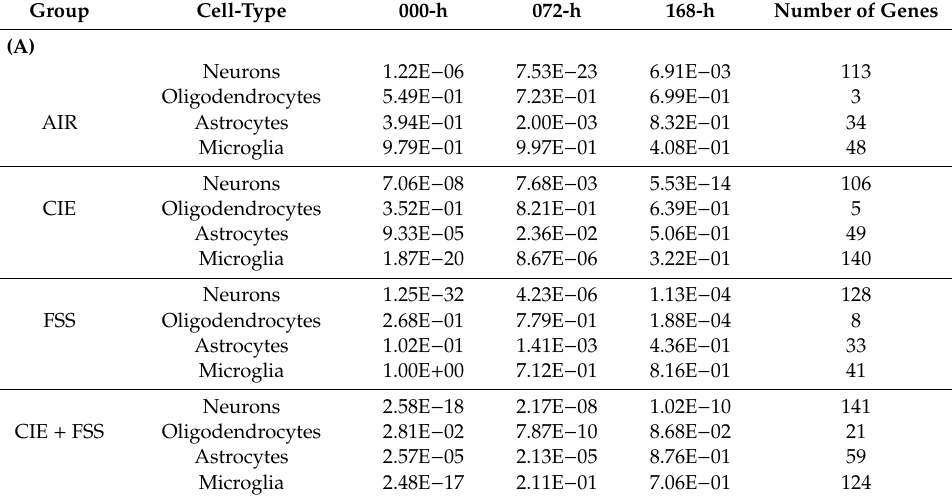
Table 2. CNS cell-type analysis of di ff erential expressed genes for CTL, CIE, FSS, and CIE + FSS at microglia) represented by genes with 10-fold expression were evaluated for the overrepresentation of (A) increased and (B) di ff erentially expressed genes. The number of genes represent the union of significant genes determined for each behavioral group across the 0-h, 72-h, and 168-h collected